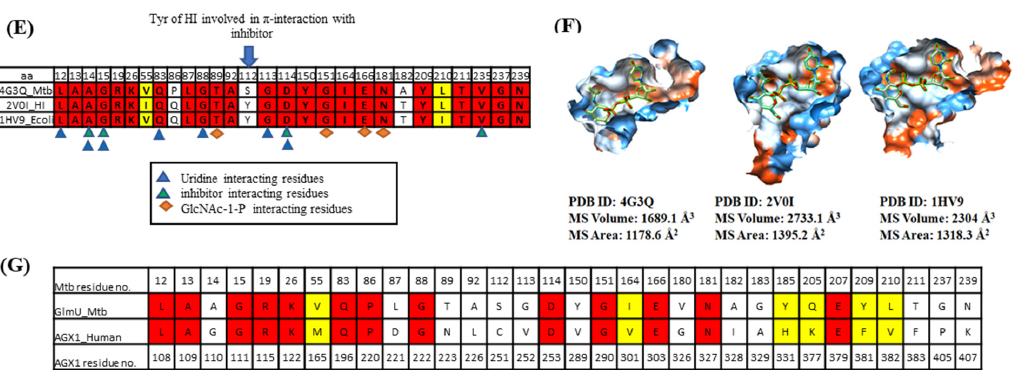
Figure 2. ( A ) Comparison of MtbGlmU with Human AGX1. ( B ) Structural alignment of apo forms of Mtb (PDB ID: 3D98), HI (PDB ID: 2V0H) and E. coli (PDB ID: 1FXJ). ( C ) Structural comparison of apo, UD1 and inhibitor bound HI structures. ( D ) Alignment of Mtb GlmU structures; the three forms apo (PDB ID: 3D98), closed (PDB ID: 4G3Q) and GlcNAc-1-P bound (PDB ID: 4HCQ) structures are aligned ( E ) Structure based sequence alignment of pocket residues of N-terminal GlmUMtb with HI